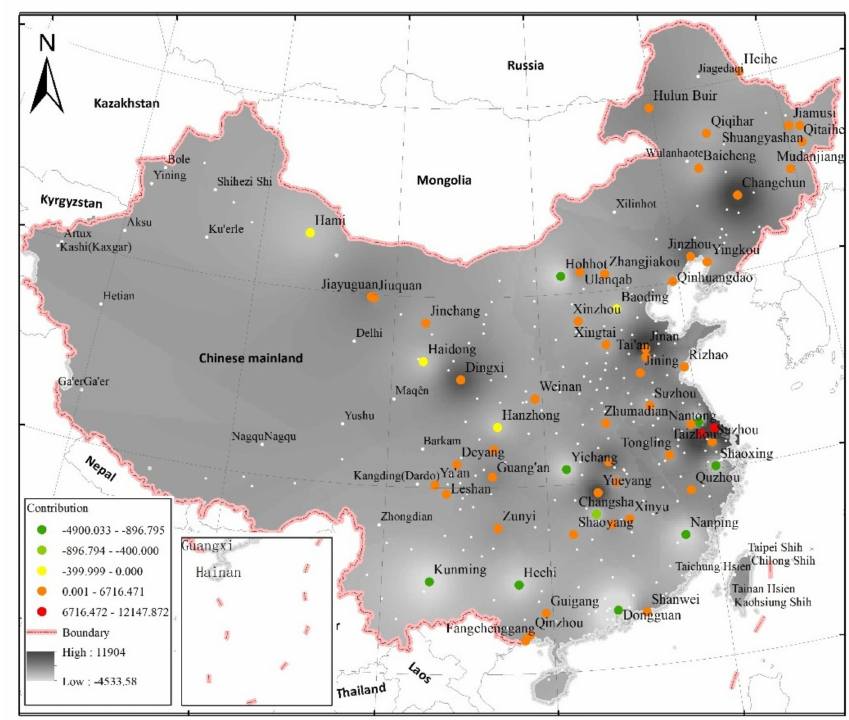
Figure A6. Contribution from the indicator GRPSIMD (proportion of secondary industry gross regional product in municipal district) to land-use intensity revealed in the city-based assessment.